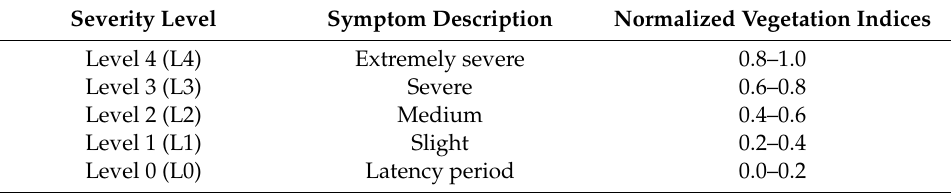
Table 2. Gradings of cotton root rot pixels based on normalized vegetation